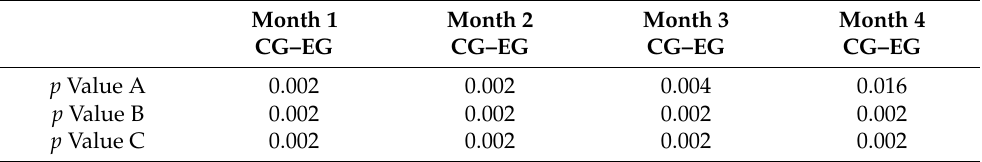
Table 4. Non-parametric test of the sign comparing the